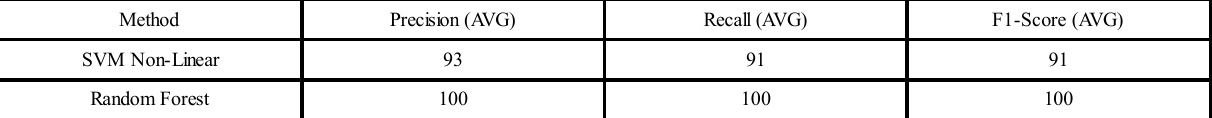
TABLE 10. PRECISION, RECALL AND F1 AVERAGE SCORE TARGETING CLASS